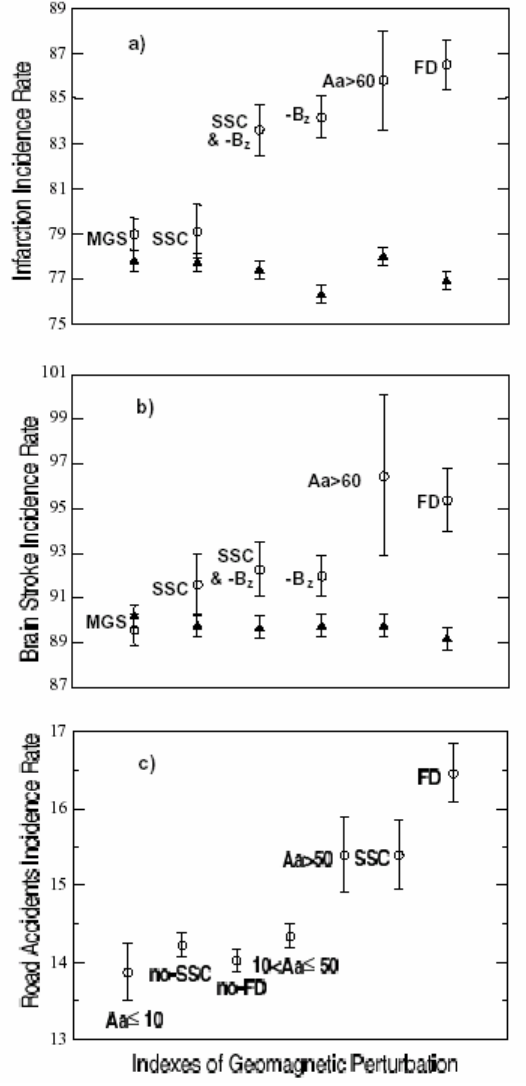
Fig.1. Fig. 1. Myocardial infarction (a) , brain stroke (b) , and road accident